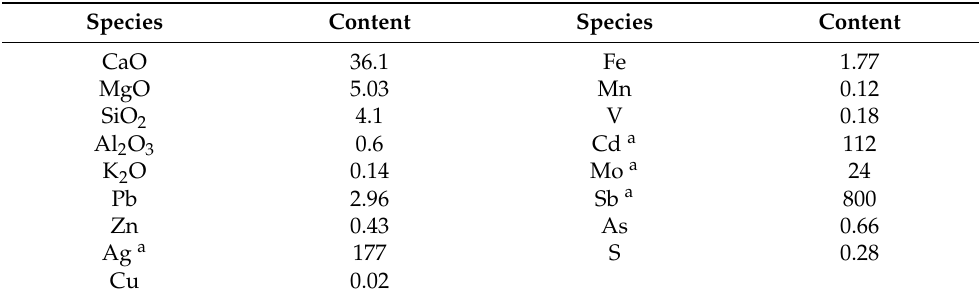
Table 1. X-ray fluorescence (XRF) spectrometry results of complex oxidized Pb-Ag ore sample (mass fraction,